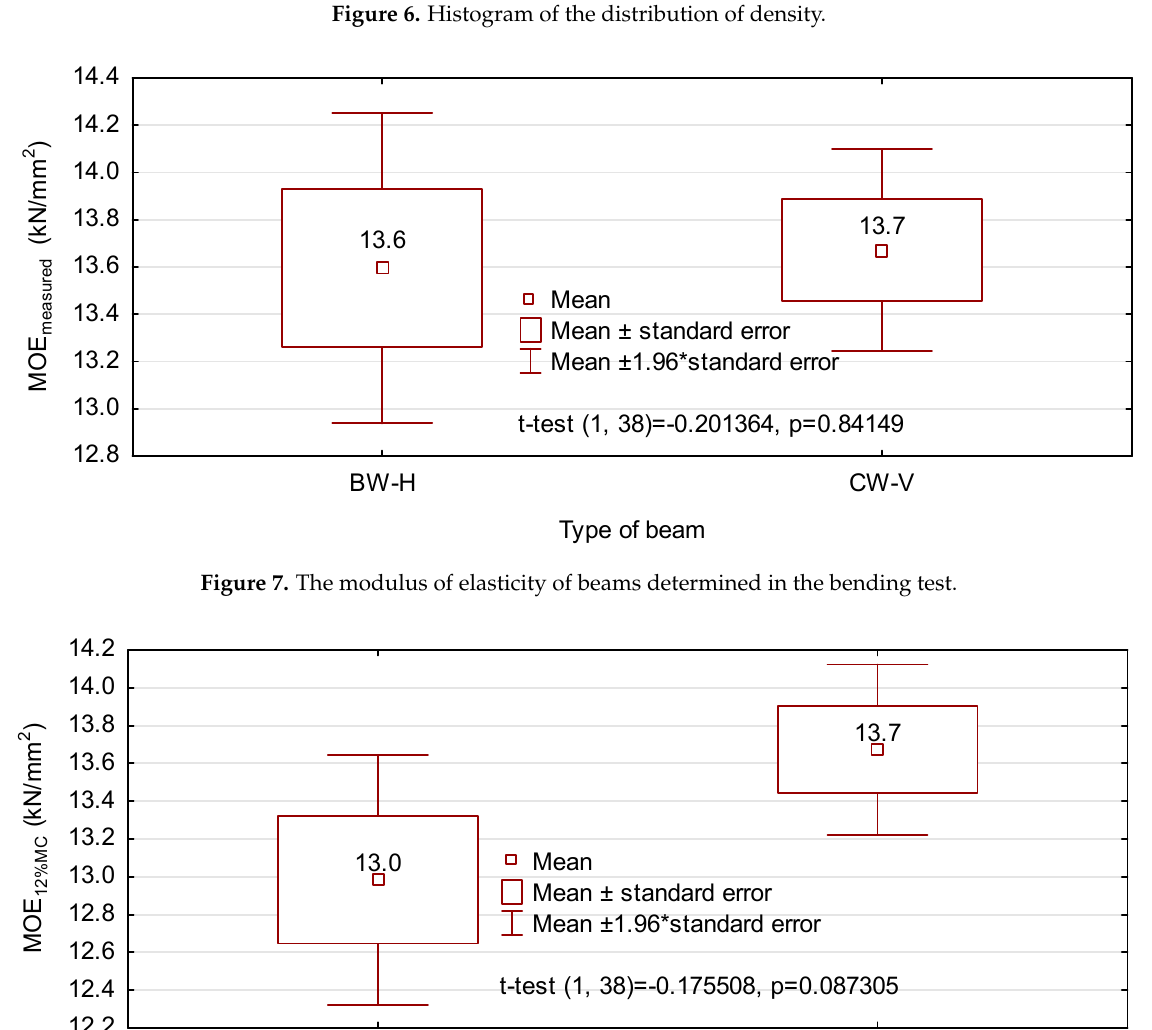
Figure 7. The modulus of elasticity of beams determined in the bending test.